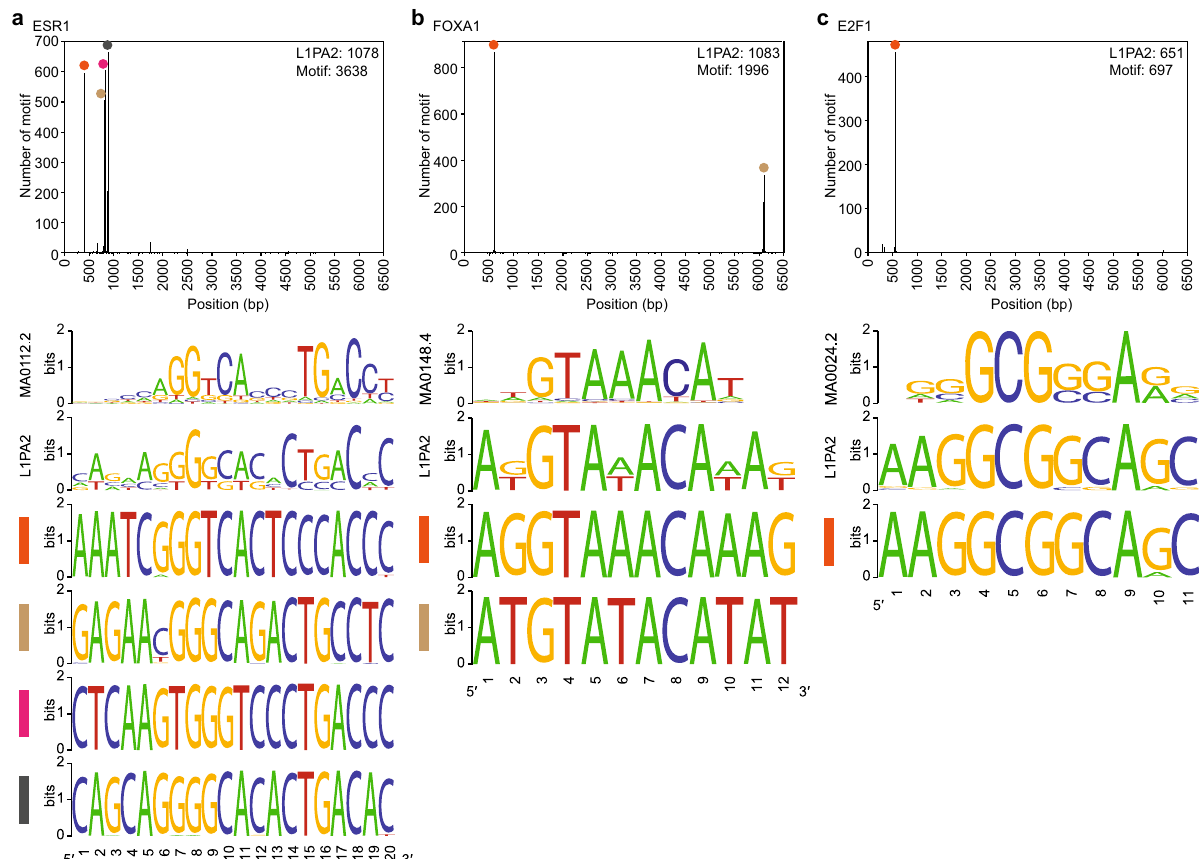
Figure 7. Oncogenic TF binding motifs are conserved in the 5 ′ UTR of L1PA2 transposons. Motif analysis was performed to identify the binding motifs for ( a ) ESR1, ( b ) FOXA1 and ( c ) E2F1 in L1PA2 transposons. The positions of the discovered motifs in the consensus L1PA2 sequence are shown in the histograms (bin = 5 bp). The number of L1PA2 elements containing at least one statistically significant motif, and the total number of statistically significant motifs are shown. For each TF, the JASPAR sequence logo is shown, labelled with the corresponding JASPAR motif ID. The “L1PA2” sequence logo was generated using all discovered motif sequences. Each peak in the histogram is labelled with a colour, and the sequence logos generated from motifs in the corresponding bins are